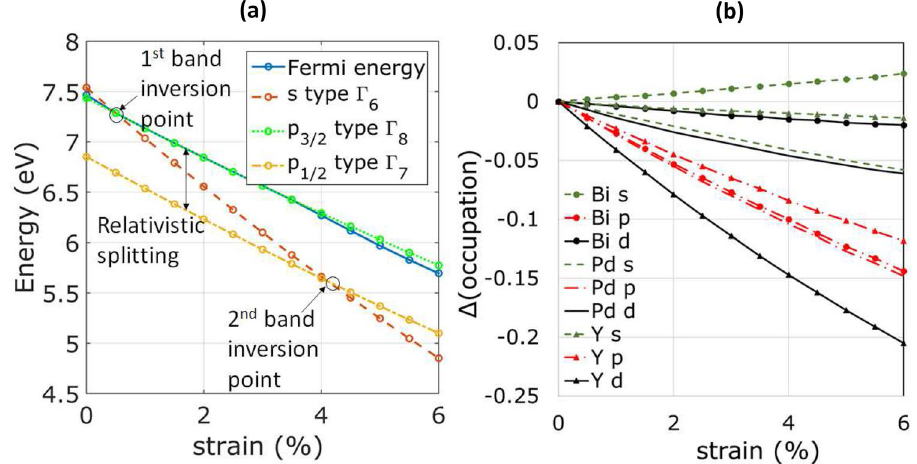
Figure 3. ( a ) Change in Fermi energy, Ŵ 6 , Ŵ 8 and Ŵ 7 with tensile strain. ( b ) Change in electronic occupation from unstrained